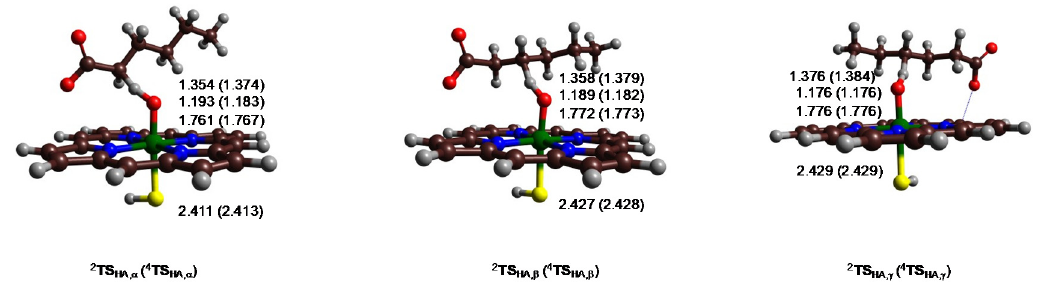
Figure 4. Optimized transition state geometries of the gas-phase density functional theory (DFT) pathways for hydrogen atom abstraction from the C α ‒ H, C β ‒ H and C γ ‒ H positions. The bond lengths are in angstroms.